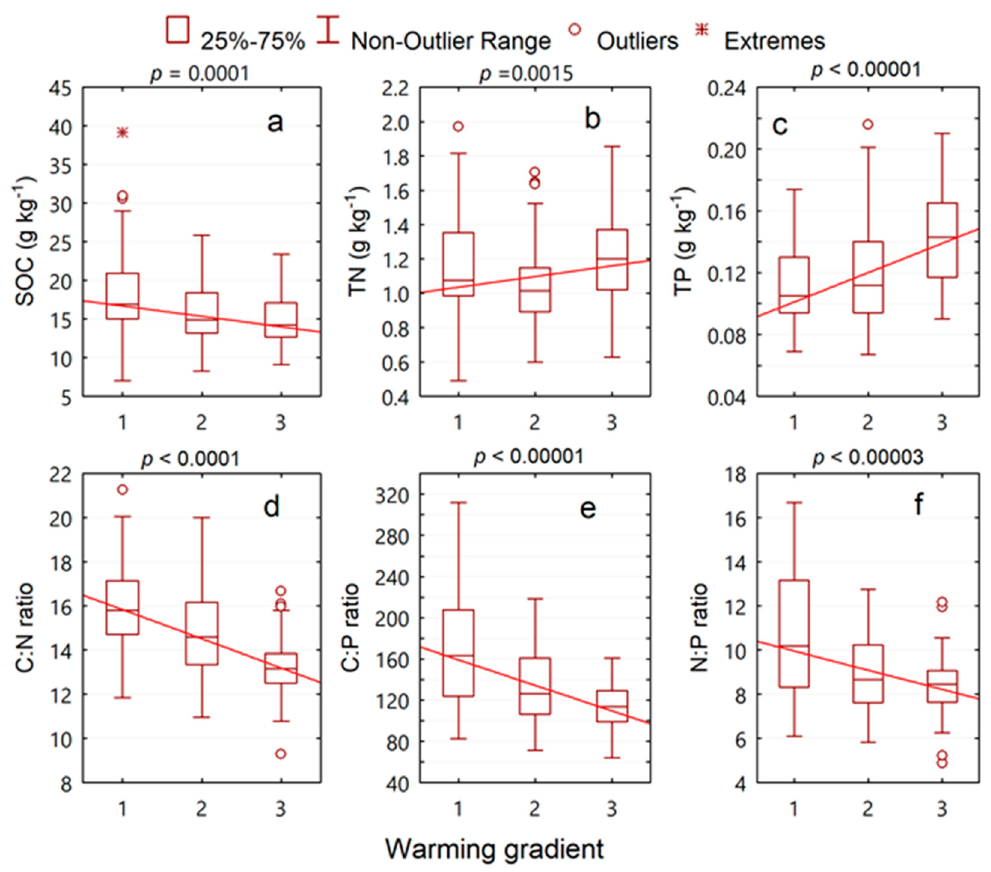
Figure 1. Boxplots showing the effect of warming gradient on soil organic carbon (SOC; a ), total nitrogen (TN; b ), total phosphorus (TP; c ), and C:N:P stoichiometric ratios ( d – f ) across an inverse elevational warming gradient.